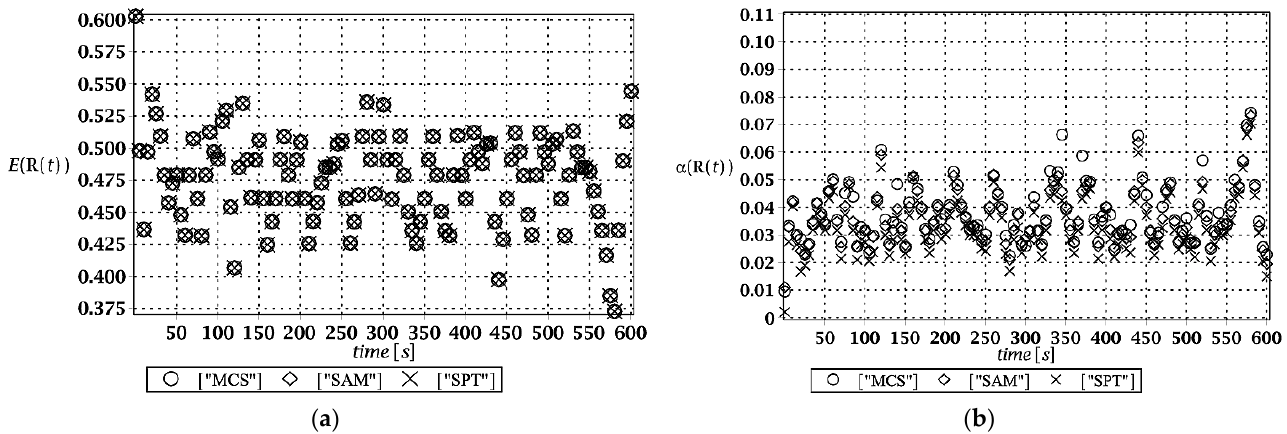
Figure 13. ( a ) The expectation of bearing capacity at the ridge of frame for uncertain wind velocity; ( b ) its CoV.